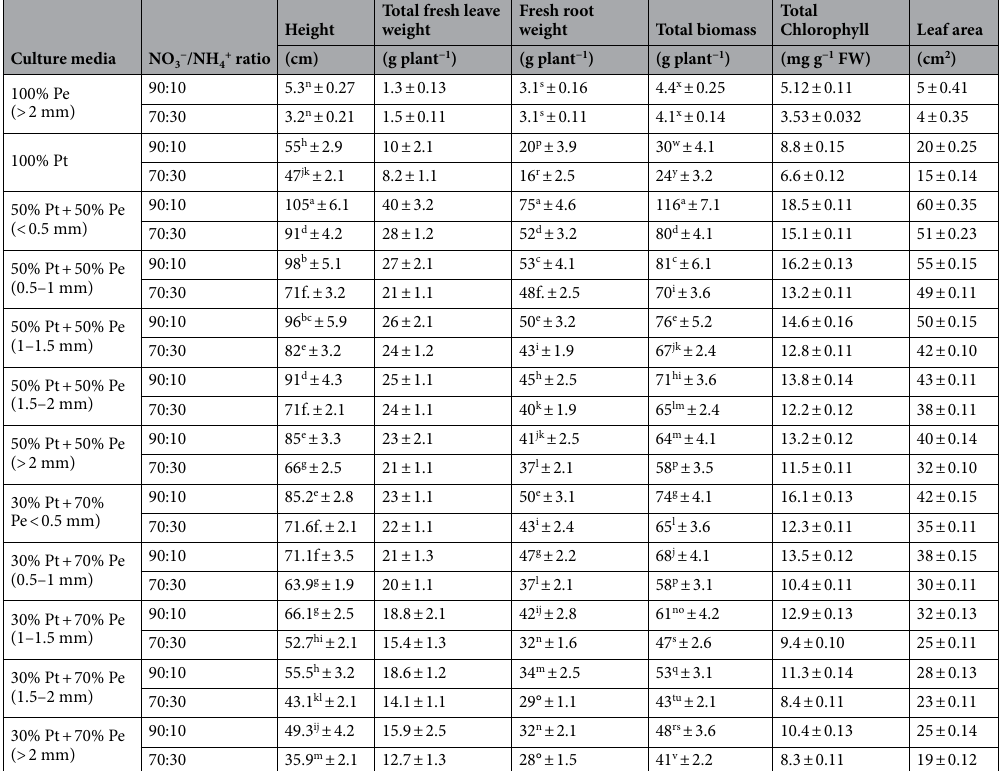
Table 2. Some morphological properties of E. purpurea growing on various culture media and NO 3 − /NH 4 + ratio at the flowering stage. Pt: peat moss and Pe: perlite. The numbers in the parentheses show perlite particle size. Each value is expressed as mean ± SD (n = 3). Means bearing different letters in the same column are significantly different ( P ≤ 0.01). The numbers show as mean ± standard deviation. The interaction effect of different treatments on total fresh leave weight, chlorophylls a and b, and leaf area was not significant.